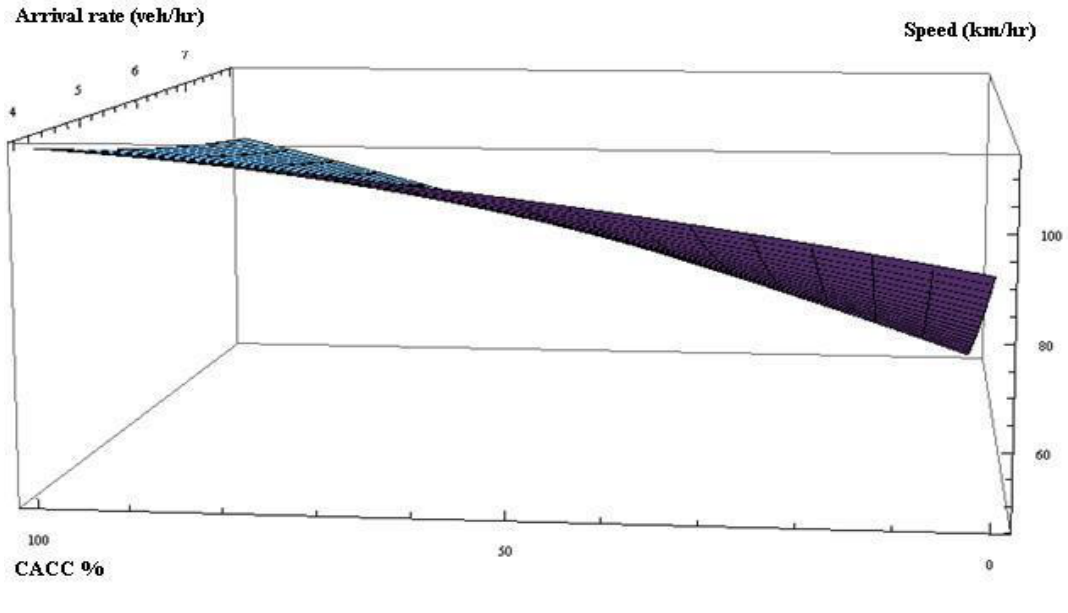
Figure 8b. 3D graph of the average speed of the generated model (with